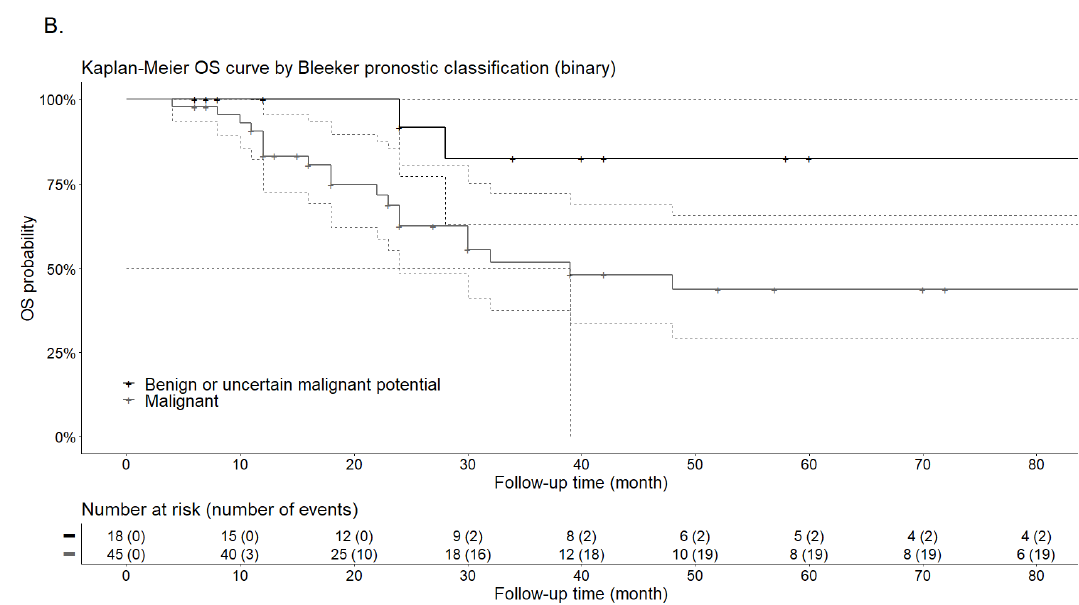
Figure 6. Kaplan–Meier OS curves by metastatic status at diagnosis ( A ) and by grouped -Bleeker classification ( B ). Table 6. Univariate and multivariate analyses of metastases features and type of first line treatment in the metastatic population related to OS ( N = 111). Multivariate analyses on 65